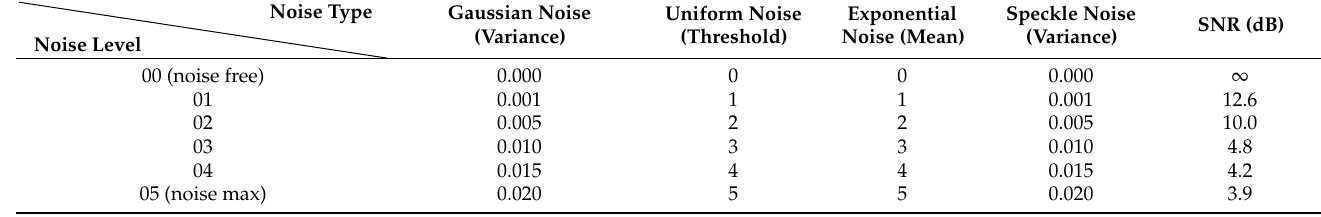
( f ) Figure 4. Partial simulated BNDF images with different SNR when the edge angle is 25 deg: ( a ) the SNR is ∞ , ( b ) the SNR is 12.6, ( c ) the SNR is 10.0, ( d ) the SNR is 4.8, ( e ) the SNR is 4.2, ( f ) the SNR is 3.9. Table 2. Noise parameter and SNR of different noise levels for different noise types. Noise Type Noise Level Gaussian Noise (Variance) Uniform Noise (Threshold) Exponential Noise (Mean) Speckle Noise (Variance) SNR (dB)